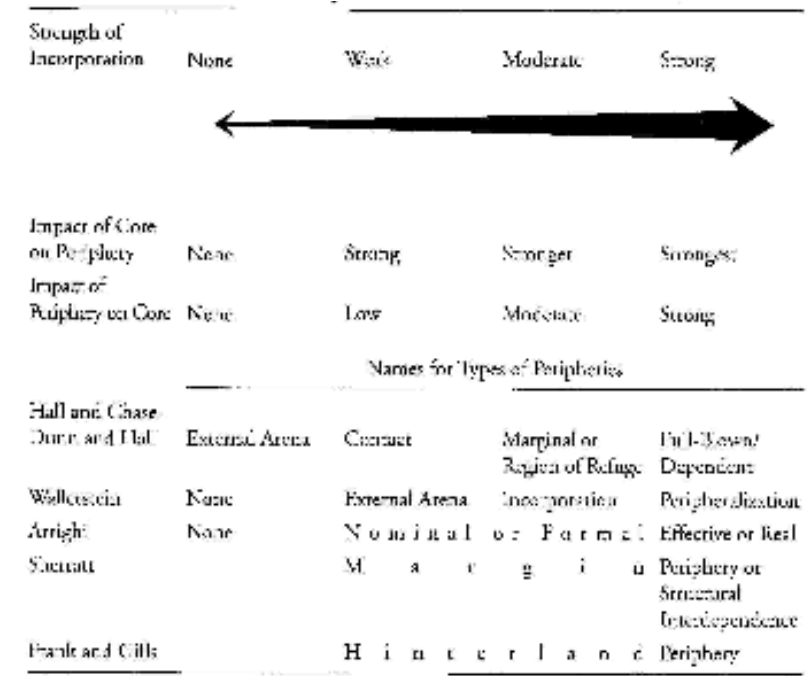
Figure 4: The Continuum of Incorporation